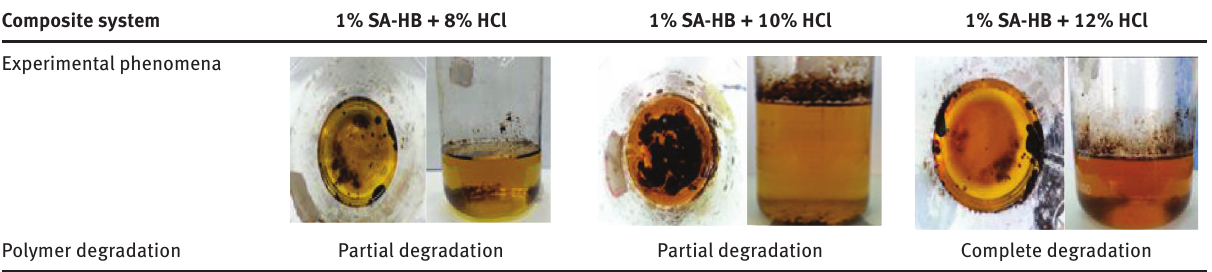
Table 7: Degradation effect of different concentrations of HCl.